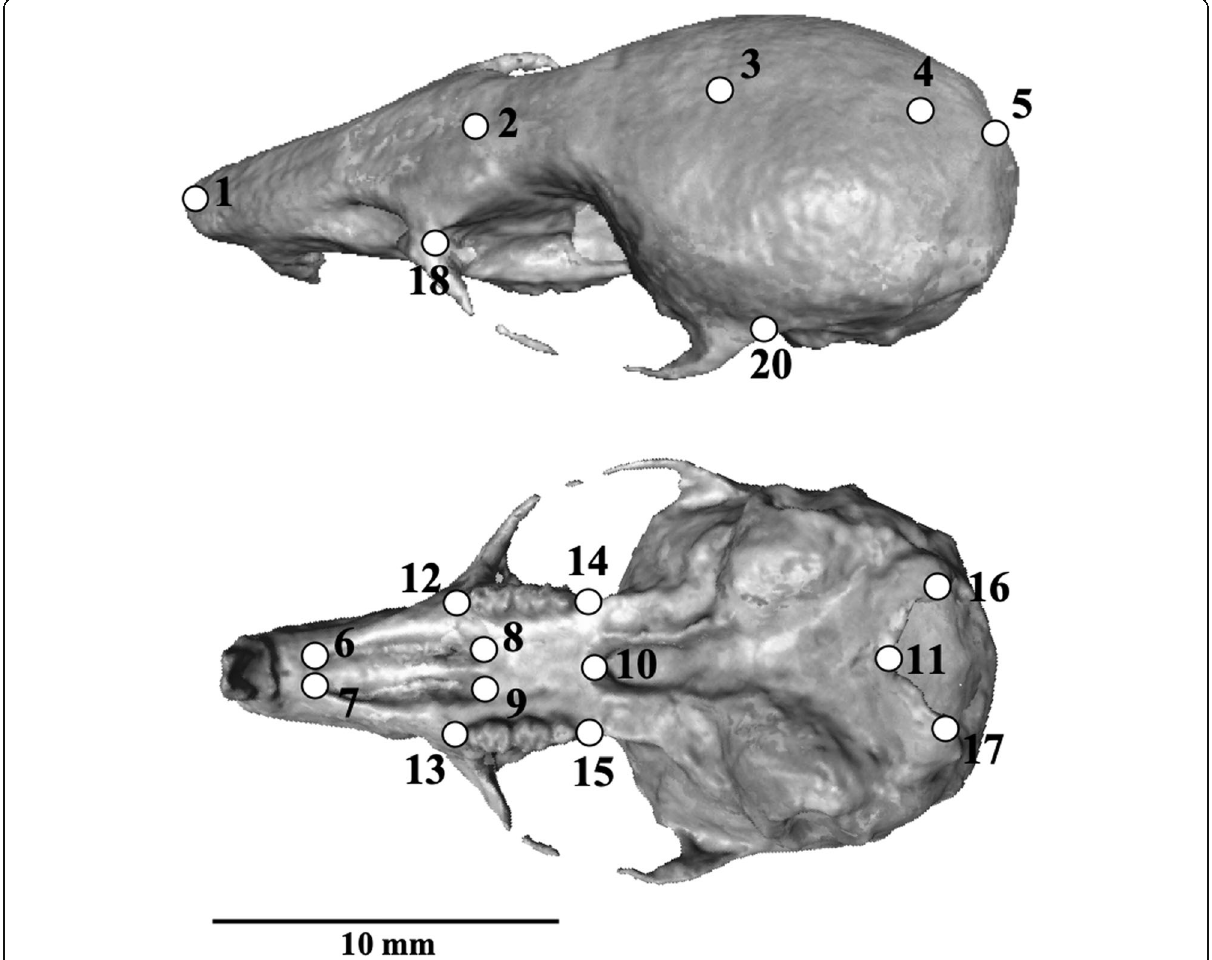
Fig. 2 Anatomical location of the 21 landmarks used in this study for three-dimensional geometric morphometric